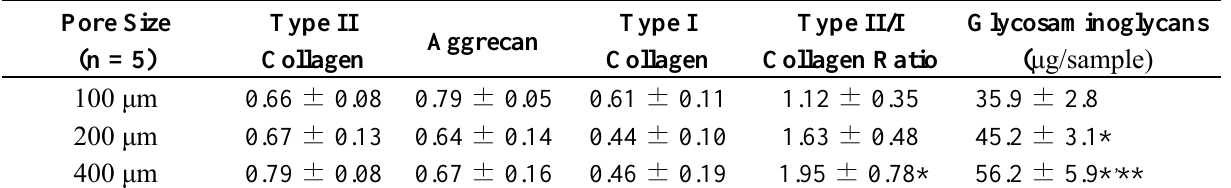
Table 4. Effects of scaffold pore size on gene expression of cartilage specific ECM and glycosaminoglycans product of chondrocytes at 28 days after cultivation [17]. Pore Size